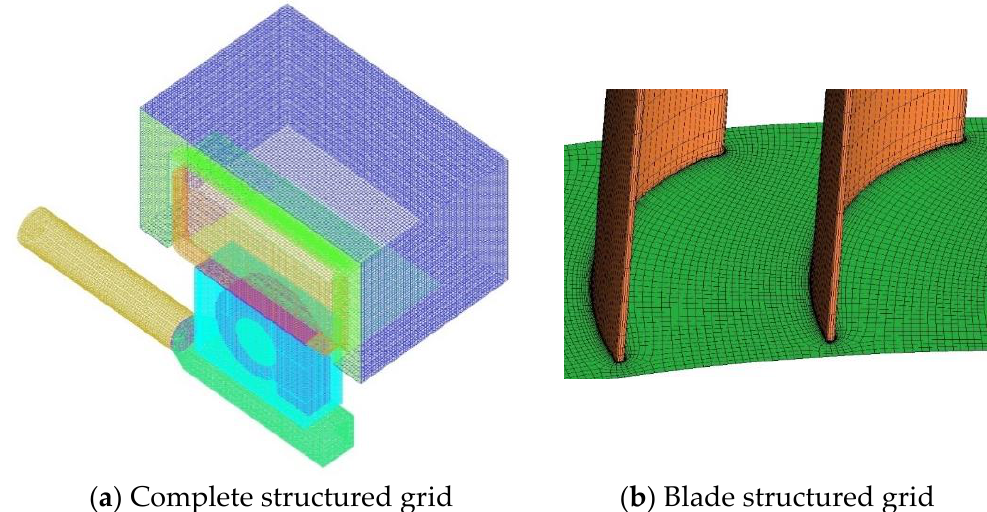
Figure 3. Integrated stove exhaust system calculation model grid.